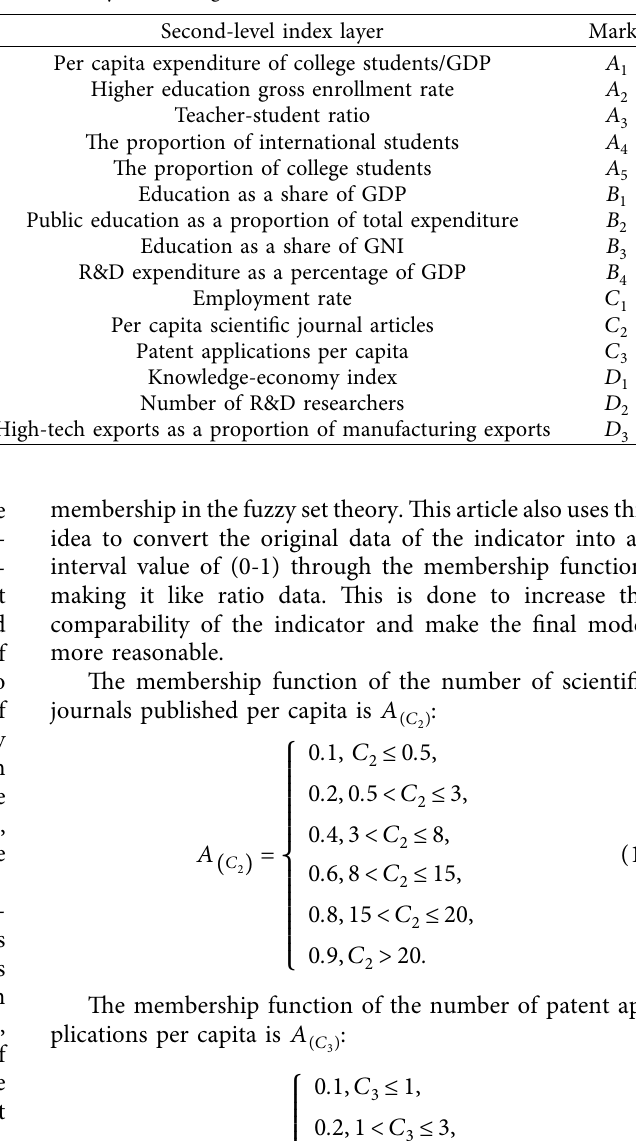
Table 2: Comprehensive evaluation index system of higher